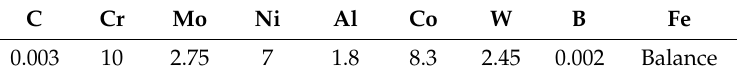
Table 1. The composition of the alloy studied in weight